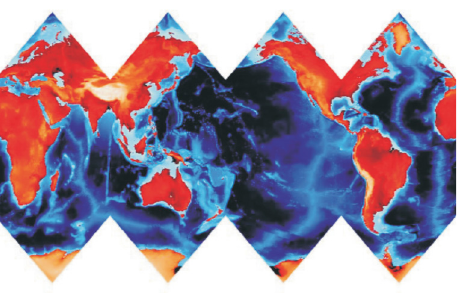
Fig. 6. Map of the Earth in the HEALPIX projection (http://www.das.inpe.br/school/AdvancedCourse/ pdfs/Gorski_lecture.pdf)